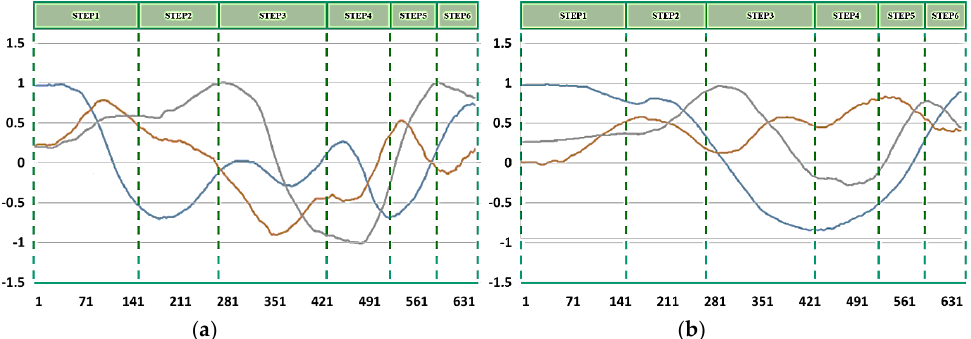
Figure 13. Complete action signal of the left hand : x-axis acceleration signals (blue line); y-axis acceleration signals (orange line); z-axis acceleration signals (gray line). ( a ) forearm, ( b ) upper arm.